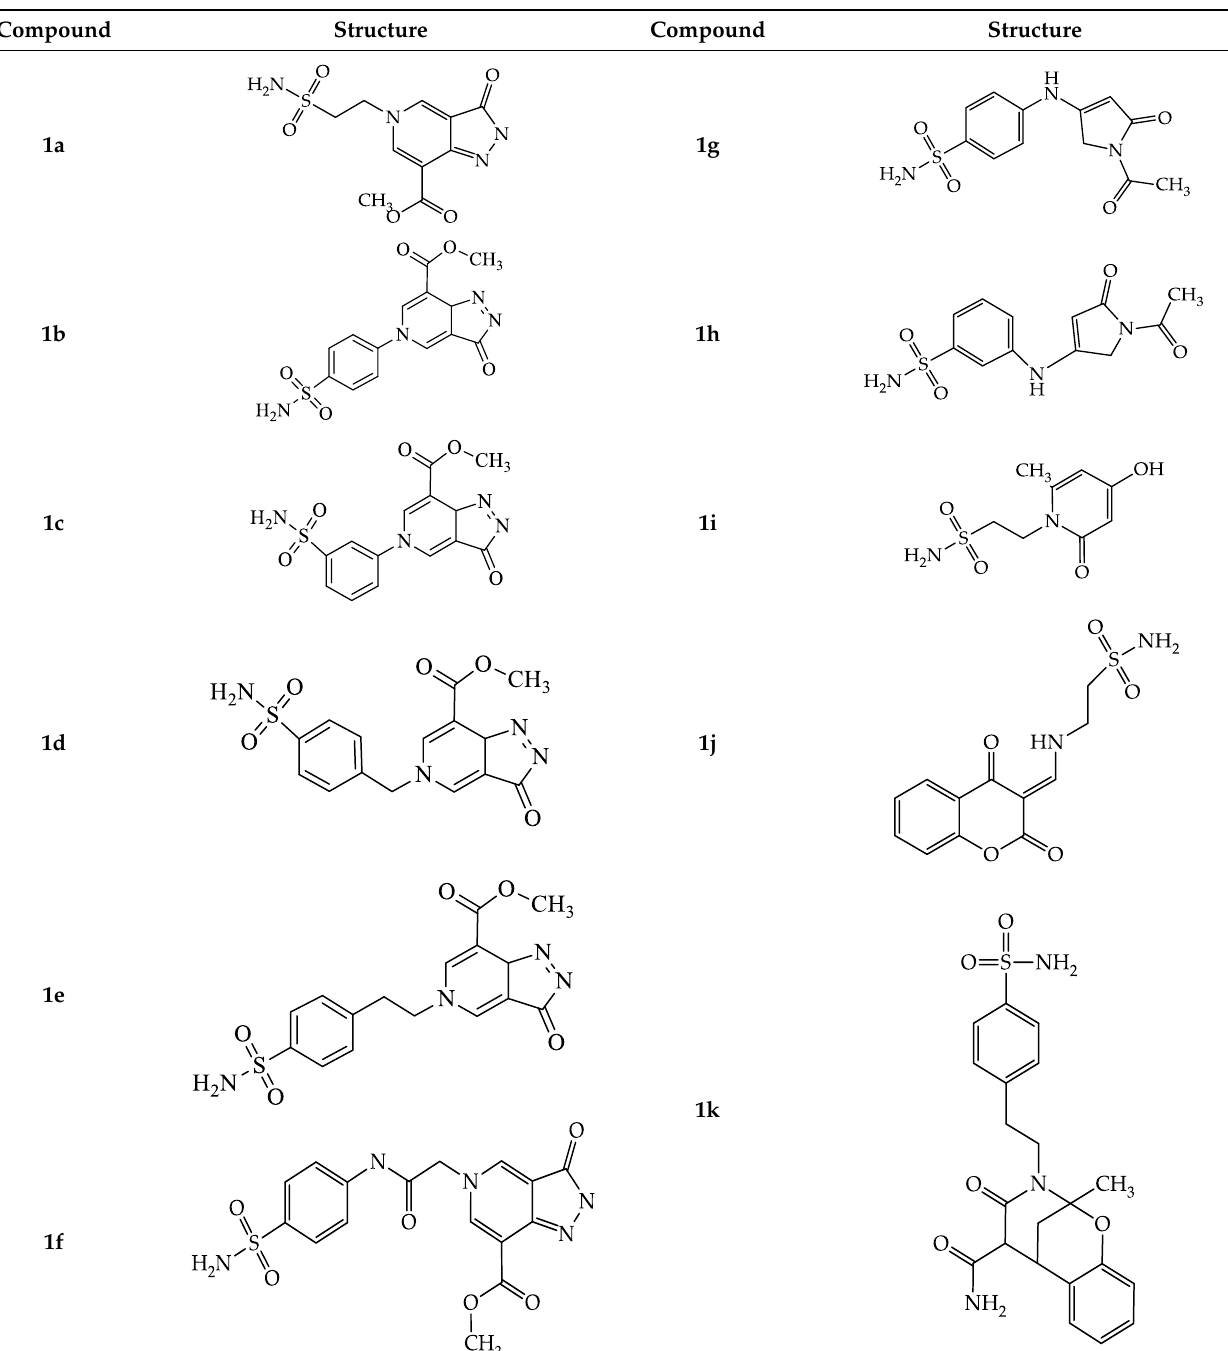
Table 1 . Structure of synthesized compounds 1a-1k .